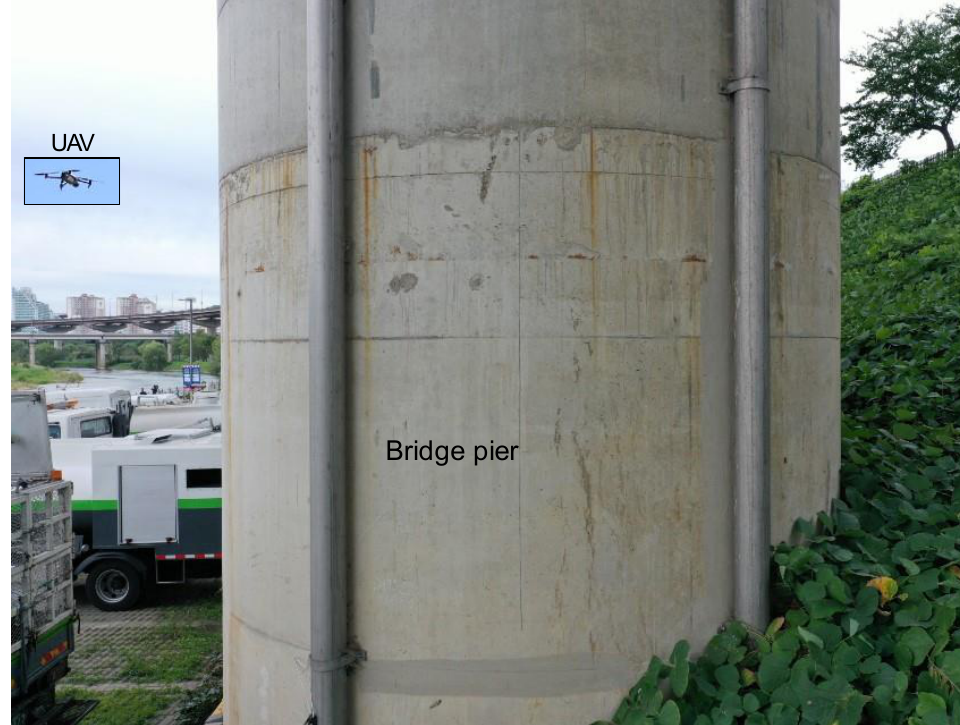
Figure 5. Representative image showing unmanned aerial vehicle (UAV)-based prototype used for bridge pier inspection.